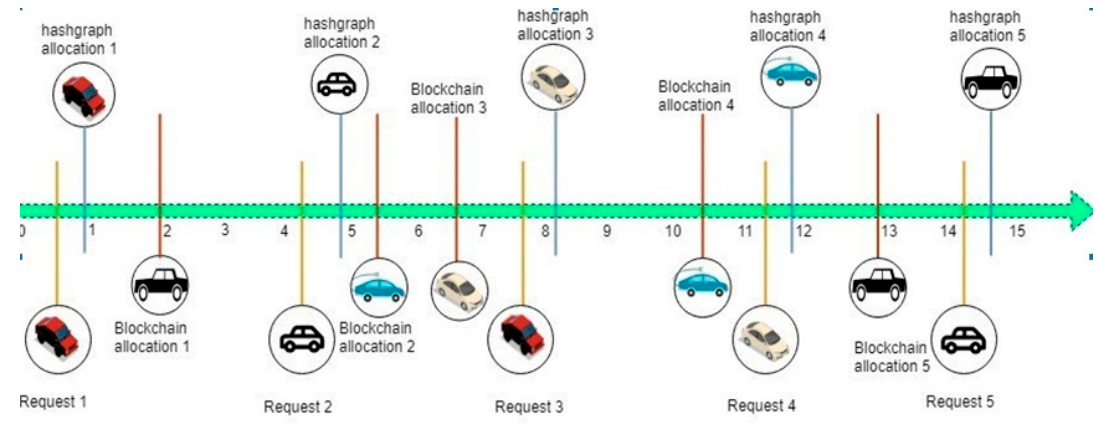
Figure 2. Transaction-based comparison between a hashgraph and a blockchain with respect to time.